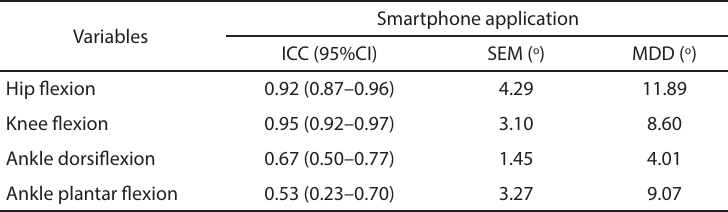
Table 2. Intra-tester reliability results of the smartphone application (CA) for active hip, knee and ankle